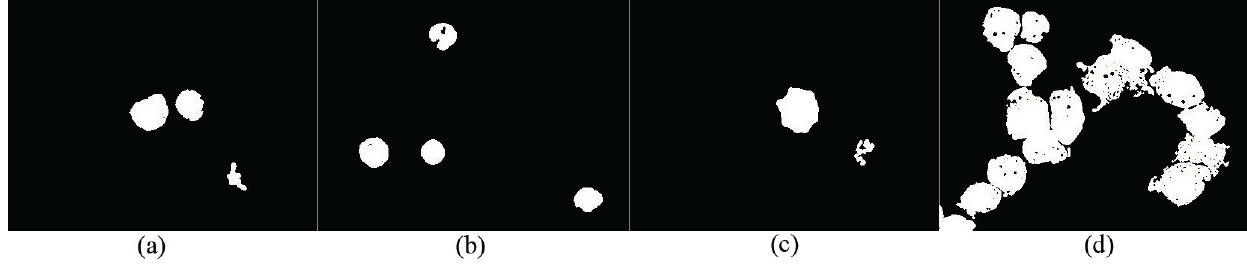
Figure 10. WBC segmentation results of four images in Figure 5.